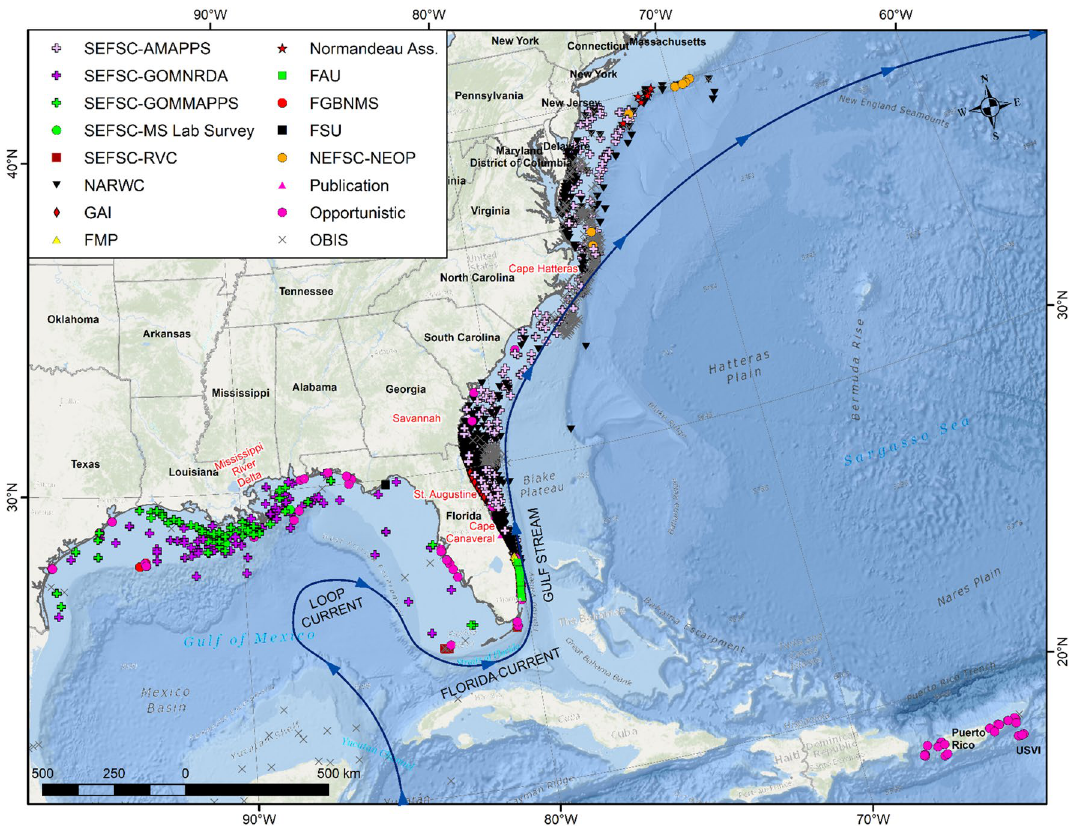
Figure 1. Reported sightings of manta rays (1925–2020) relative to regional landmarks and ocean currents. Sightings from Southeast Fisheries Science Center (SEFSC) Atlantic Marine Assessment Program for Protected Species (AMAPPS), Gulf of Mexico Marine Assessment Program for Protected Species (GOMAPPS), Gulf of Mexico Natural Resource Damage Assessment (GOMNRDA) aerial surveys, Mississippi Lab pelagic longline surveys (MS Lab Survey), and Reef Visual Census (RVC) SCUBA-based survey; Florida Atlantic University (FAU) Kajiura Lab aerial elasmobranch surveys, Flower Garden Banks National Marine Sanctuary (FGBNMS) staff sightings, boat-based and aerial surveys by trained Florida Manta Project (FMP) staff, Florida State University (FSU) Grubbs Lab elasmobranch gillnet surveys, Georgia Aquarium (GAI) aerial surveys, Ocean Biodiversity Information System (OBIS) open-access data, North Atlantic Right Whale Consortium (NARWC) ship-based and aerial surveys, Northeast Fisheries Science Center (NEFSC) Northeast Observer Program (NEOP) trawl encounters, APEM and Normandeau Associates Aerial Digital Baseline Survey of Marine Wildlife in Support of Offshore Wind Energy for New York State Energy Research and Development Authority (NYSERDA) and U.S. Bureau of Ocean Energy Management, and verified opportunistic sightings reported to the authors or pulled from social media and news reports. Basemap used with permission from ESRI Ocean Basemap and its partners, showing marine water body names, undersea feature names, and derived depth values in meters. Map generated in ArcMap 10.8.1 (https:// suppo rt. esri. com/ en/ produ cts/ deskt op/ arcgis- deskt op/ arcmap/